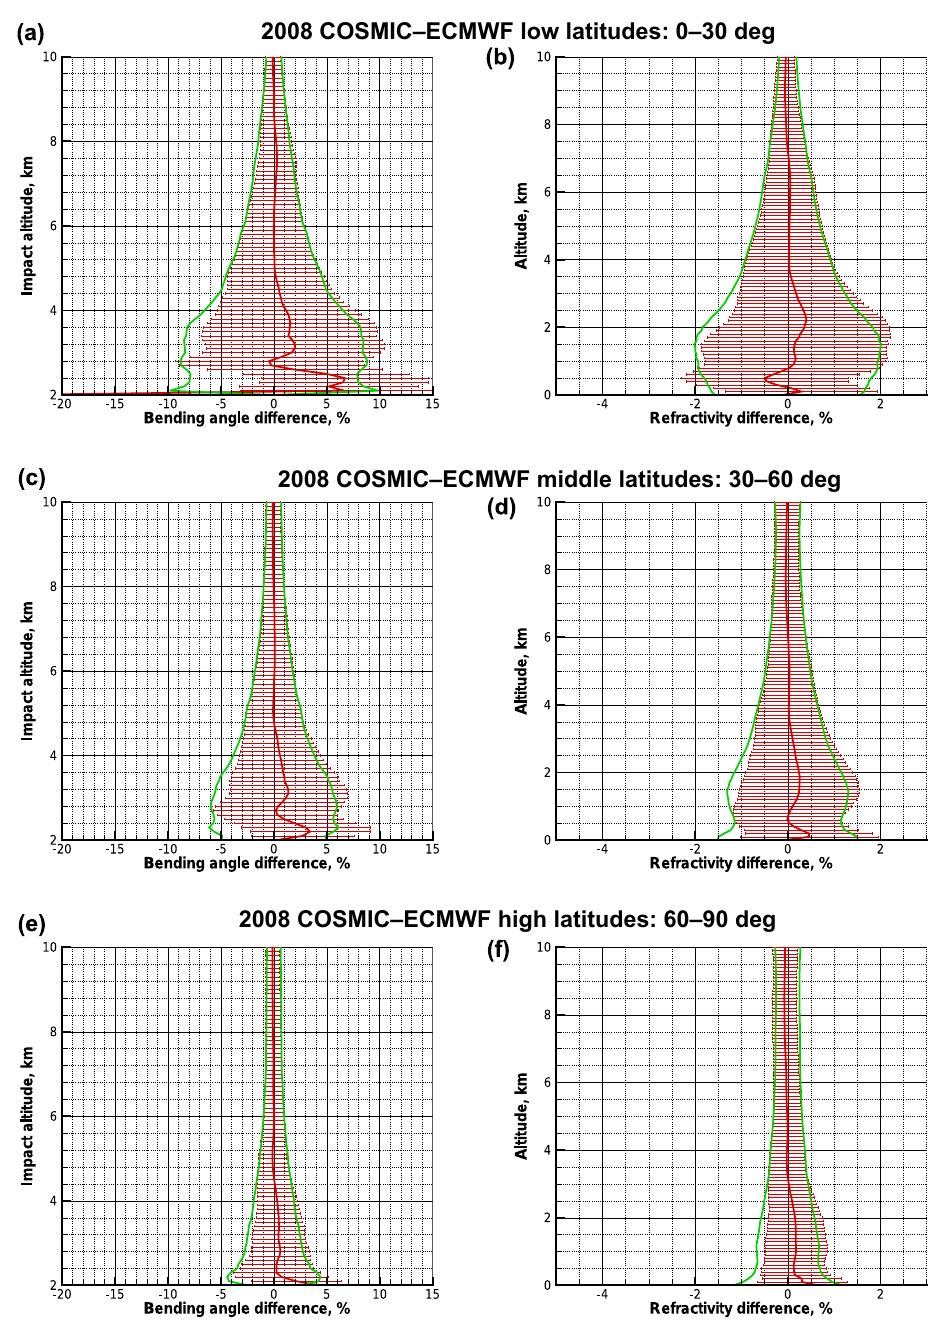
Figure 7. Deviation statistics based on BLB-corrected retrieved bending angles (after back projection of original BLB-corrected bending angles to excess phases and in turn retrieving the bending angles again): COSMIC–ECMWF difference statistics with the same layout and using the same COSMIC and ECMWF data as for Fig.